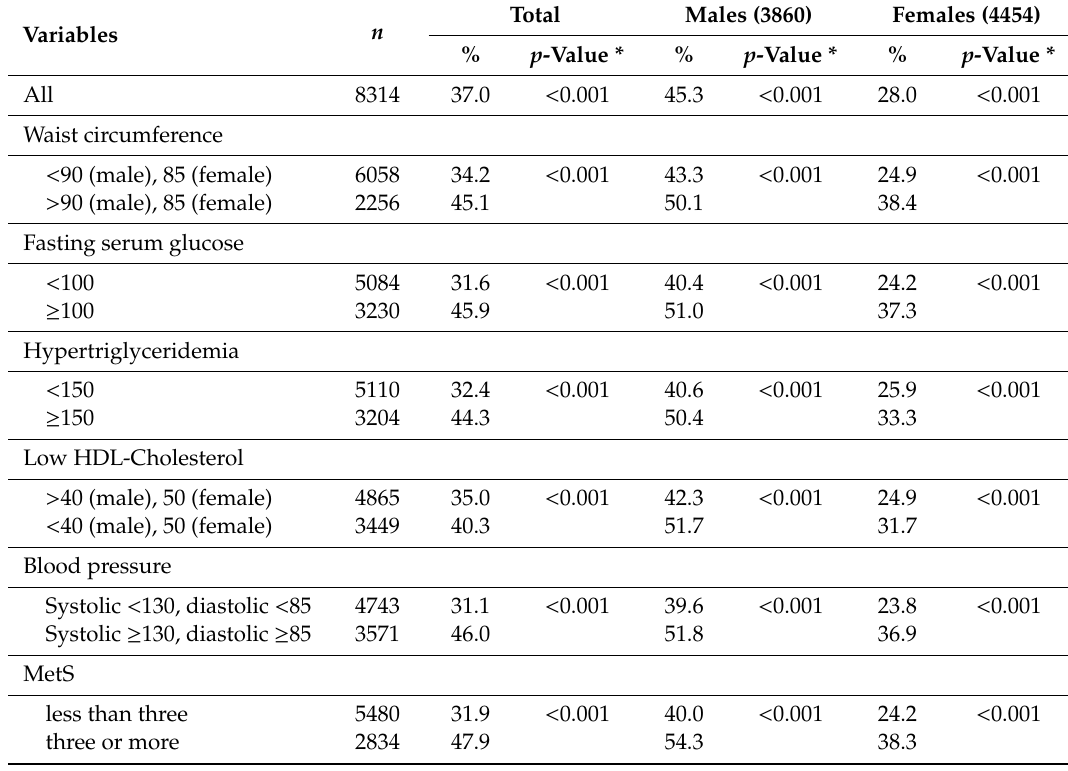
Table 1. The prevalence of periodontitis according to five components of MetS in total and by sex.